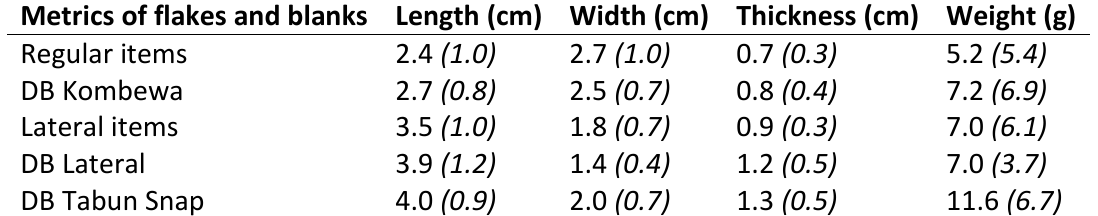
Table 4: Average metrics of blanks produced from COF, Standard deviation is in